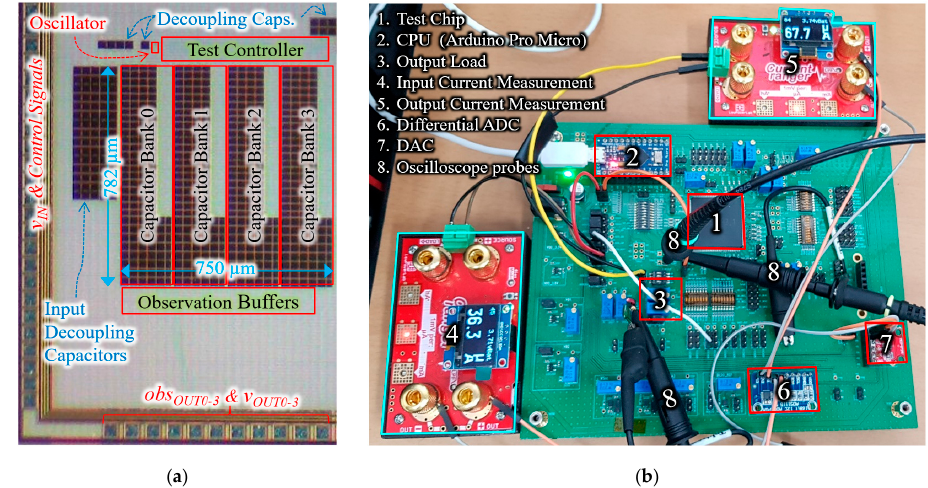
Figure 9. ( a ) Die microphotograph of the implemented proposed controller with test controller and oscillator; ( b ) measurement setup showing test PCB and o ff -PCB current measurement